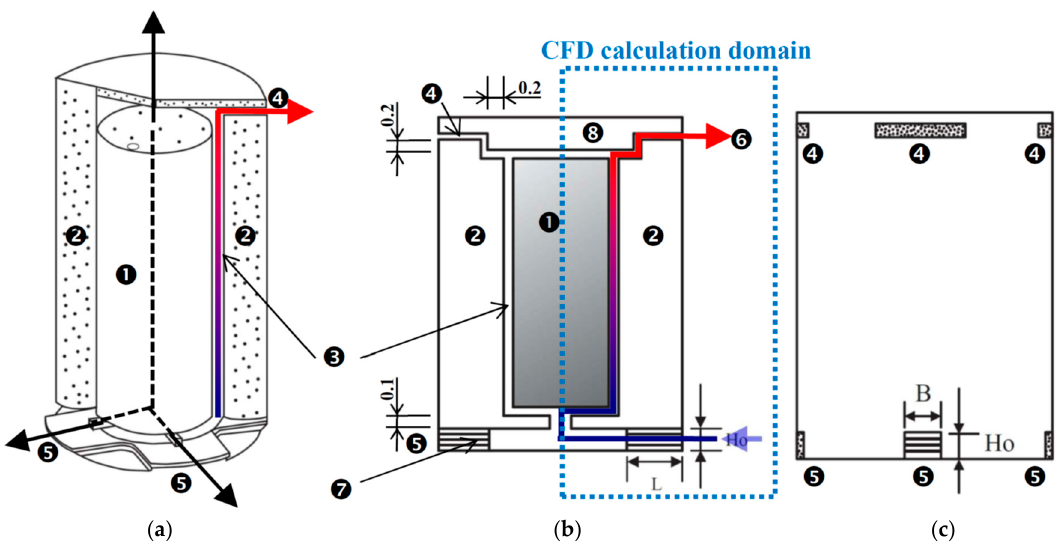
Figure 2. Schematic diagram of the investigated model (dry storage cask) (unit: m) (not to scale). ( a ) Cross-sectional view; ( b ) Sectional view; and ( c ) Front view.